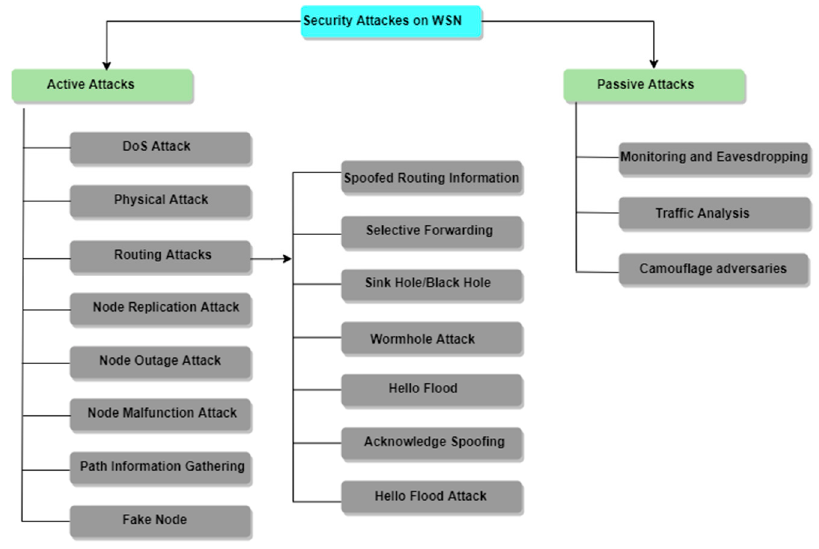
Figure 11. Security attacks on wireless sensor networks [79].